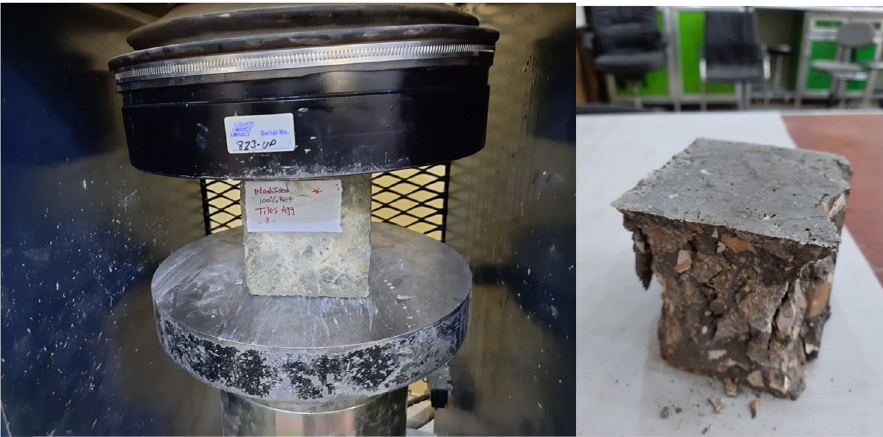
Figure 2: Compressive strength for 100% waste tile concrete – modi fi ed mix.